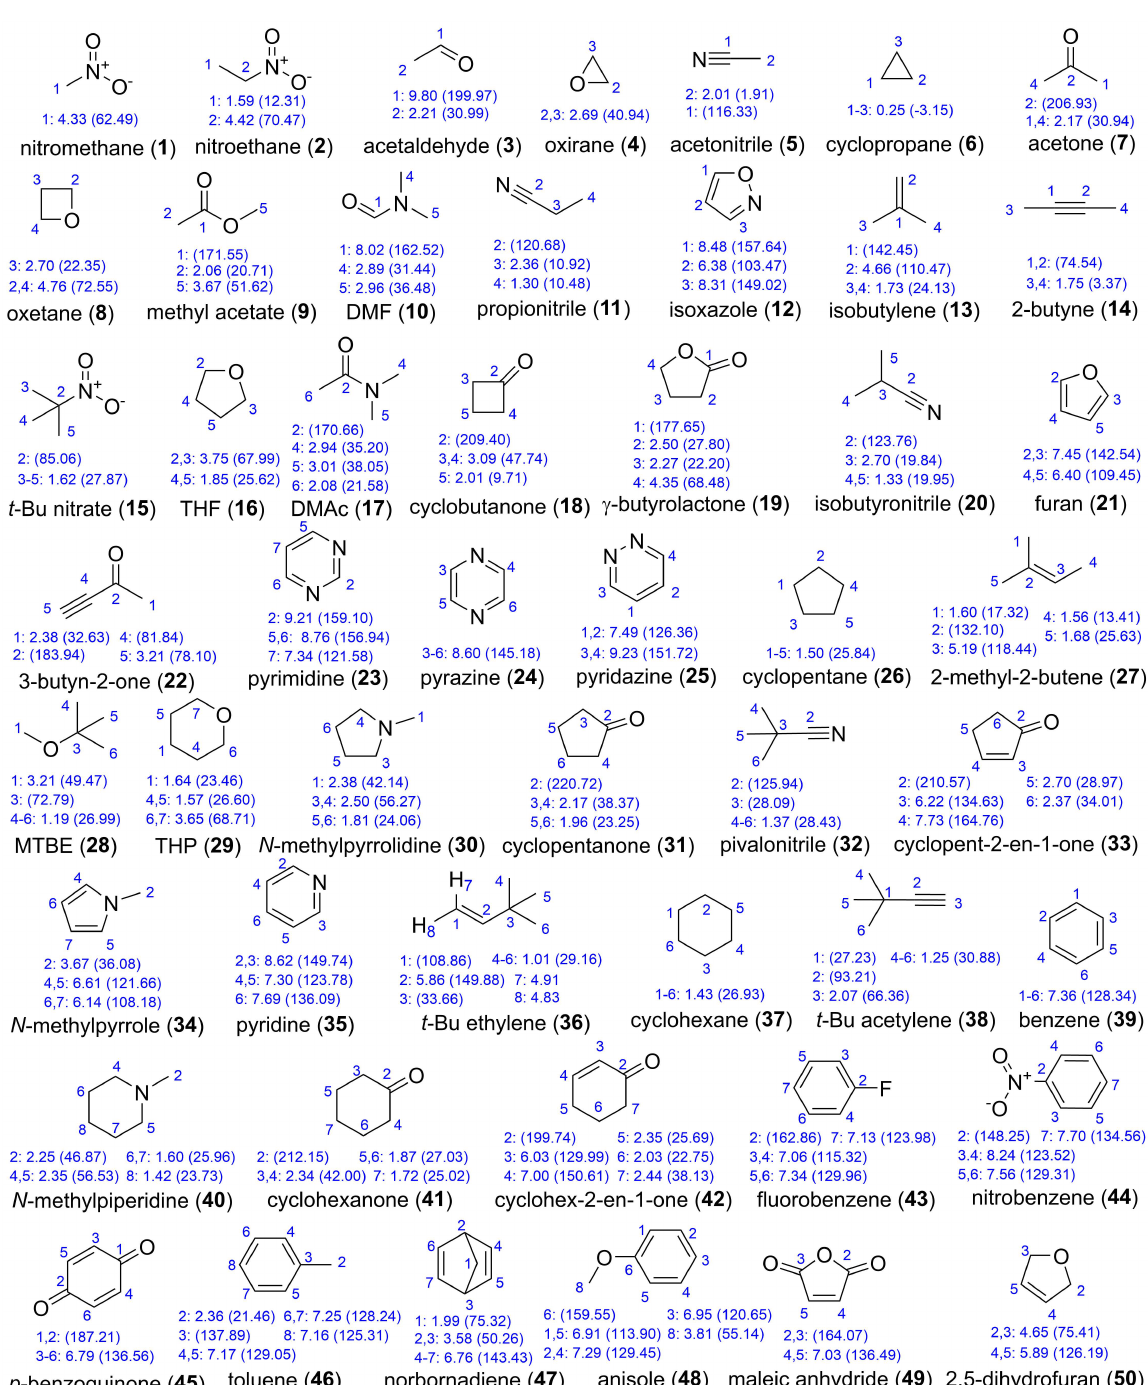
Figure 2. DELTA50 benchmark set of 50 small molecules that avoid the issues described in Figure 1. Experimental 1 H chemical shifts are provided for numbered carbon atoms with 13 C chemical shifts listed in parentheses. Numbering corresponds to that used in calculations. Experimental data were acquired on a 600 MHz NMR in CDCl 3 and referenced to TMS at 0.00 ppm for both 1 H and 13 C. A concentration-dependent study was undertaken to ensure that samples were suffi- ciently dilute to avoid deleterious aggregation using a representative subset of compounds with diverse functionalities from DELTA50: benzene, pyridazine, tetrahydrofuran (THF), 3-butyn-2-one, and fluorobenzene (Figure 3). Here, it was found that proton chemical shifts were stable within a variance of ± 0.3% at concentrations up to 50 mM. The largest